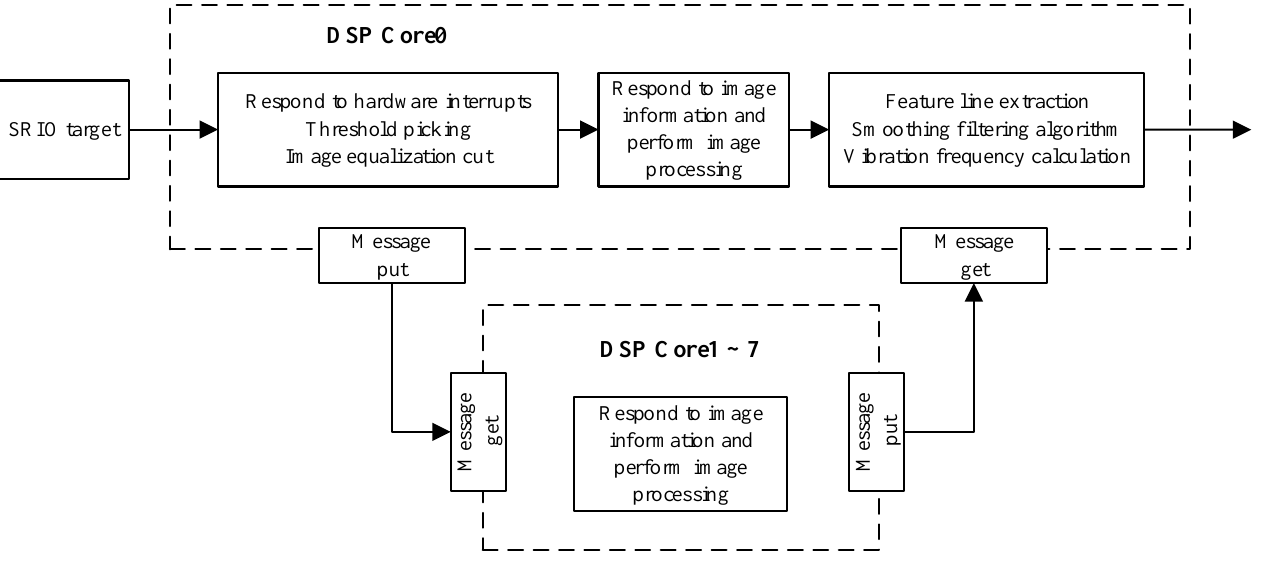
Figure 6. DSP multi-core image processing flow chart.